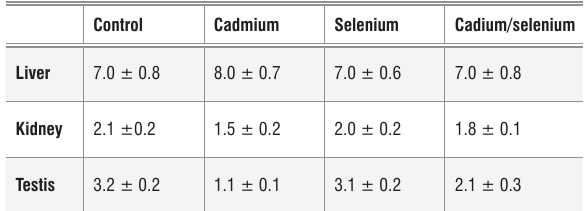
Table 1: Relative weights (g) of organs of control and treated rats after 15 days of exposure to saline (control) cadmium, selenium or cadmium and selenium Control Cadmium Selenium Cadium/selenium